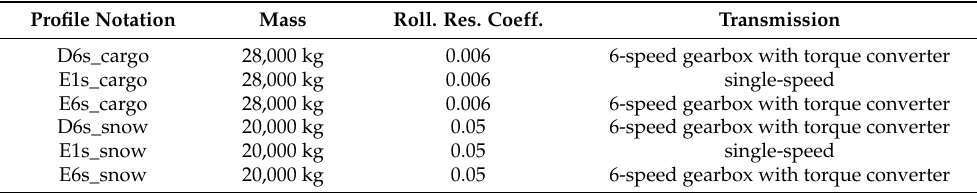
Table 3. Varying vehicle profile